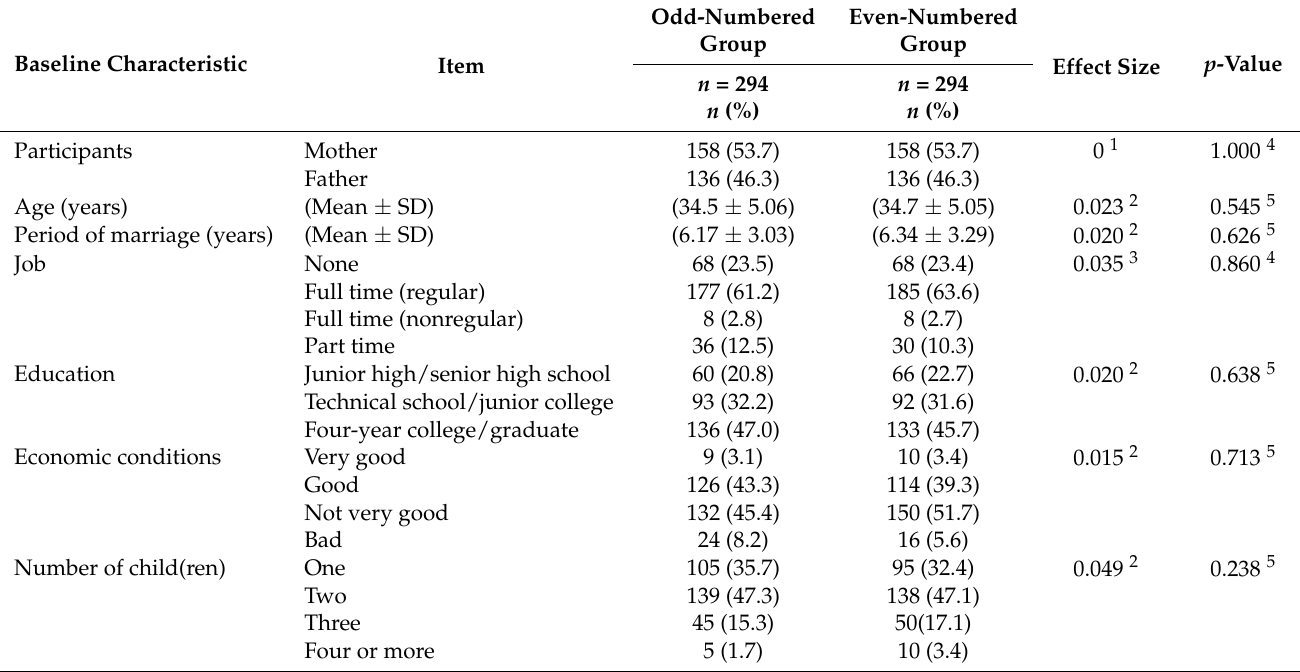
Table 1. Demographic Characteristics (N =